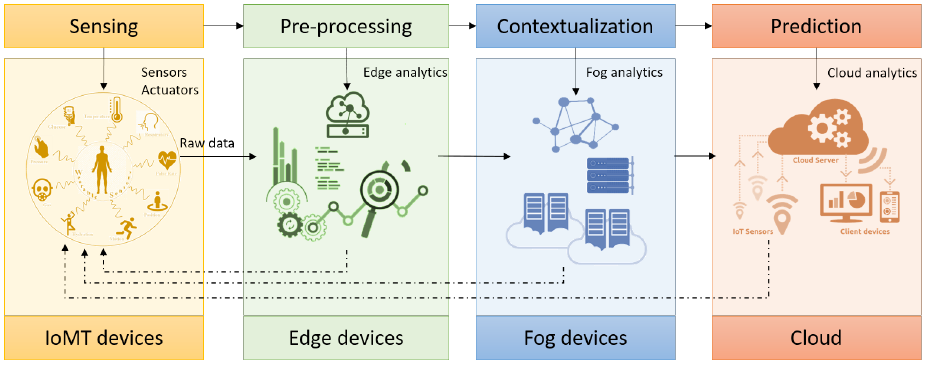
Figure 1. General layers architecture of IoMT